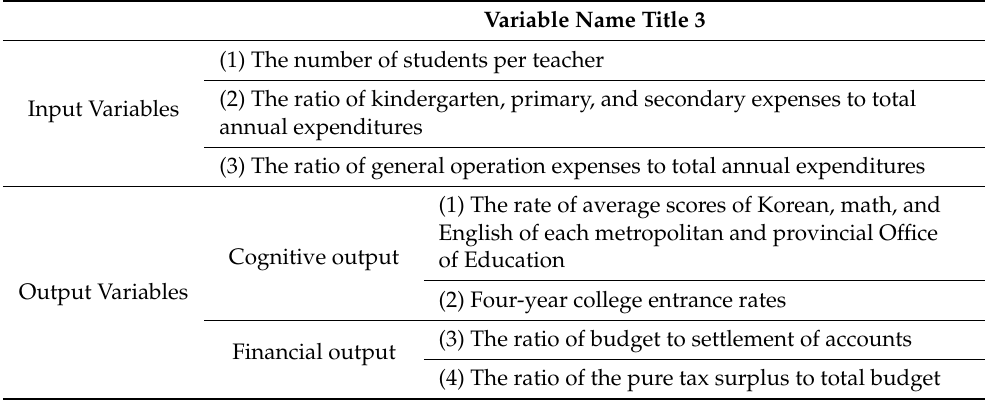
Table 1. The summary of the input variables and output variables of the DEA